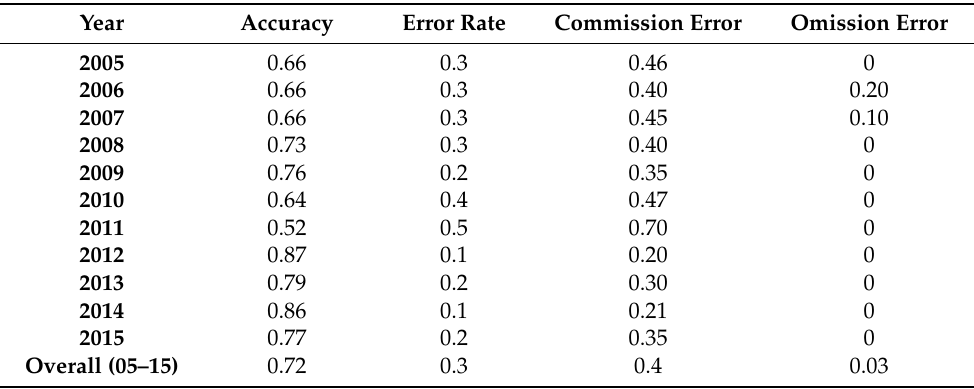
Table 2. Accuracy assessment results for the Aberdare National Park.